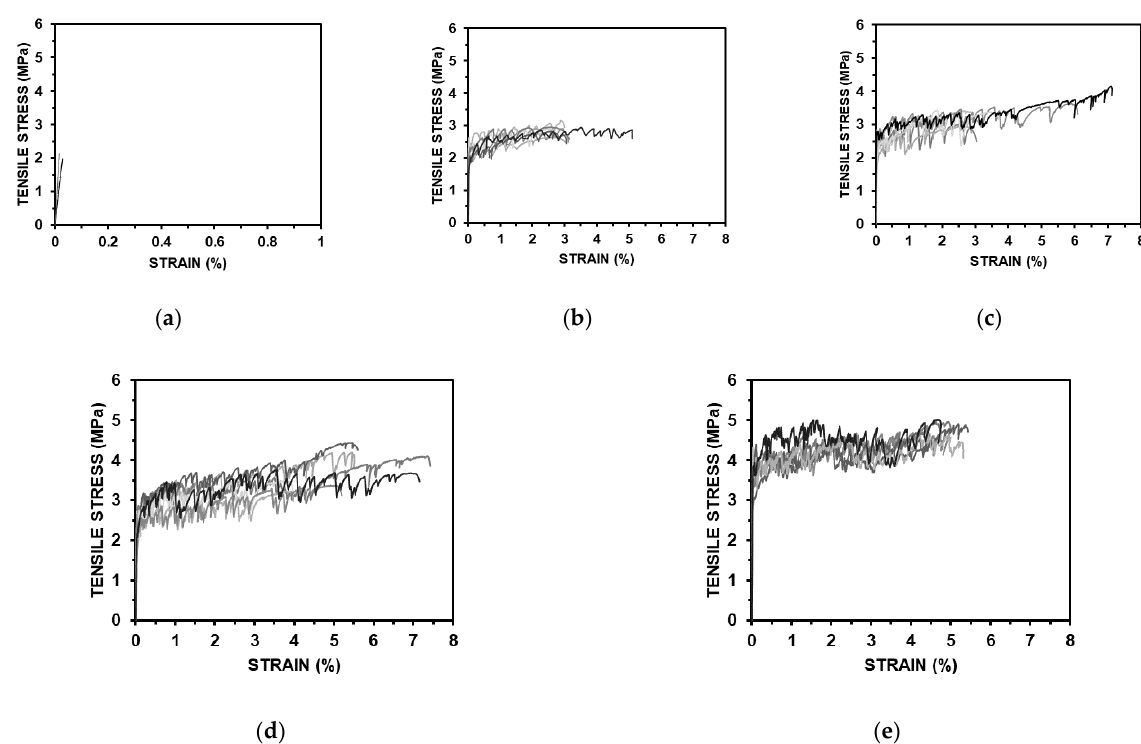
Figure 6. Direct uniaxial tensile stress – strain curves: ( a ) ASFC000 (PVA 0.00 vol.%); ( b ) ASFC100 (PVA 1.00 vol.%); ( c ) ASFC125 (PVA 1.25 vol.%); ( d ) ASFC150 (PVA 1.50 vol.%); ( e ) ASFC200 (PVA 2.00 vol.%).